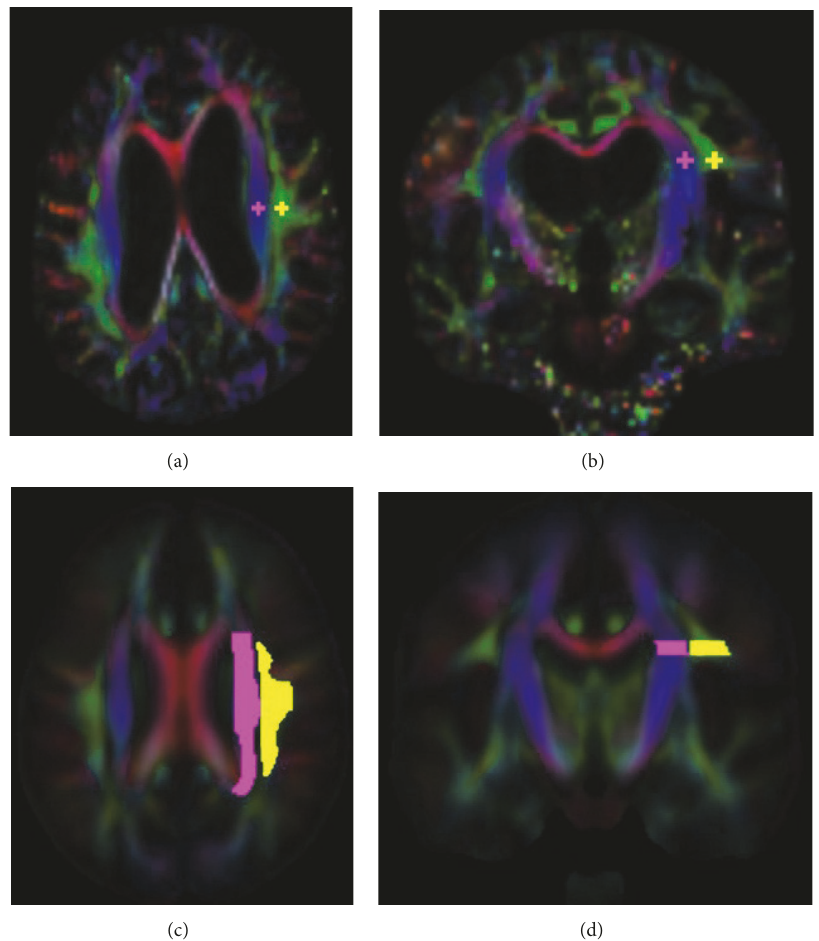
Figure 3: Region of interest (ROI) setting on manual (a, b) and atlas-based (c, d) ALPS indexes. On the manual method, 5-mm-diameter spheres were placed on the projection and association fiber areas with reference to a color-coded FA map on each patient. On the atlas-based method, the labels of the projection and association fiber areas were defined by the labels of the ICBM DTI-81 Atlas. Values of coregistered maps were retrieved using these